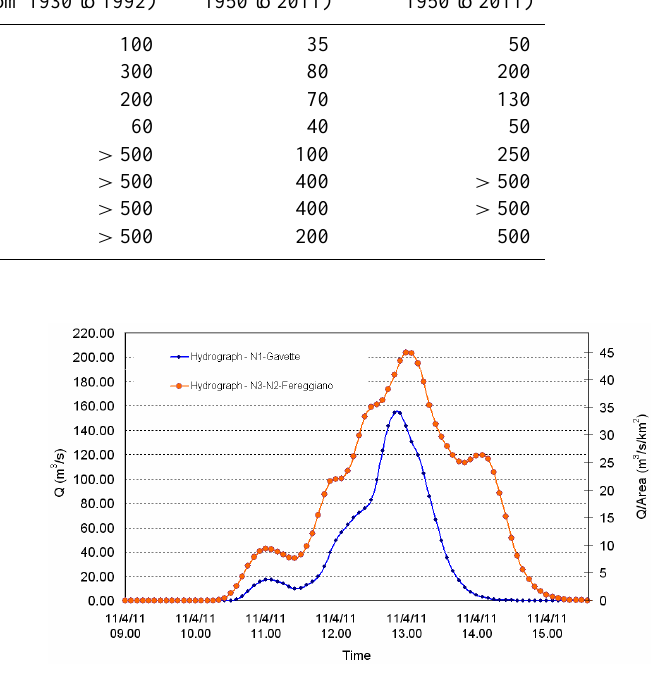
Figure 10: Fereggiano brook. Flow simulations. On the left y axis the streamflow is reported 2 Fig. 10. Fereggiano brook. Flow simulations. On the left y-axis the while on the right y axis the flow contribution per unit area is shown. On x axis the UTC time 3 streamflow is reported while on the right y-axis the flow contribu- is reported: 4 tion per unit area is shown. On x-axis the UTC time is